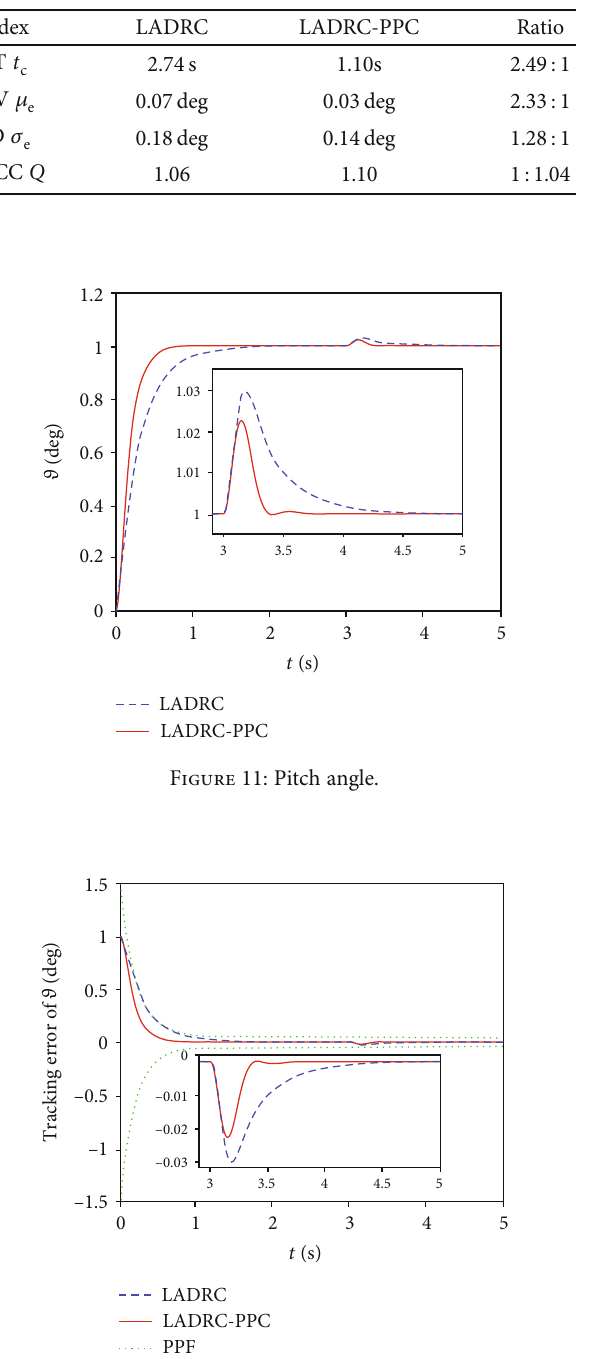
Figure 12: Tracking error of pitch angle.